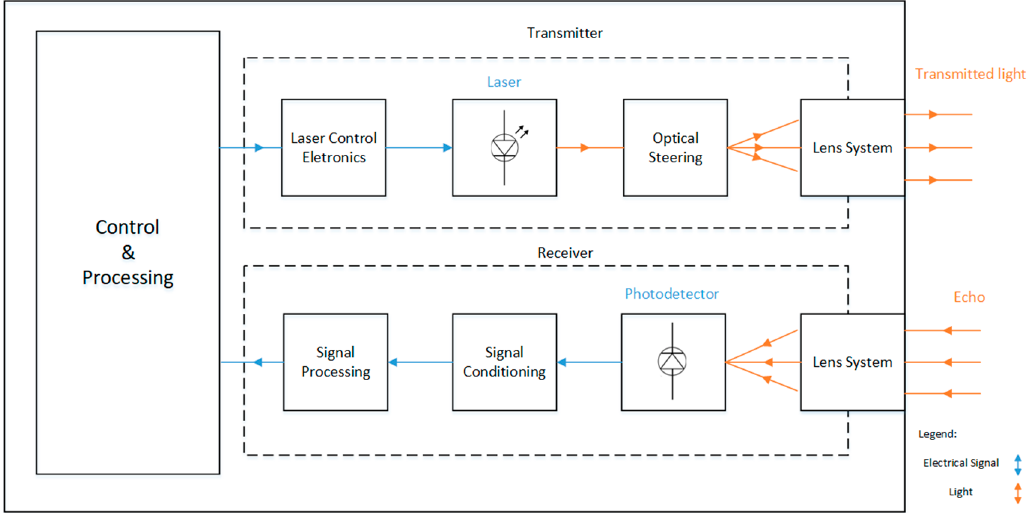
Figure 1. Basic diagram about how light detection and ranging (LiDAR) technology works.